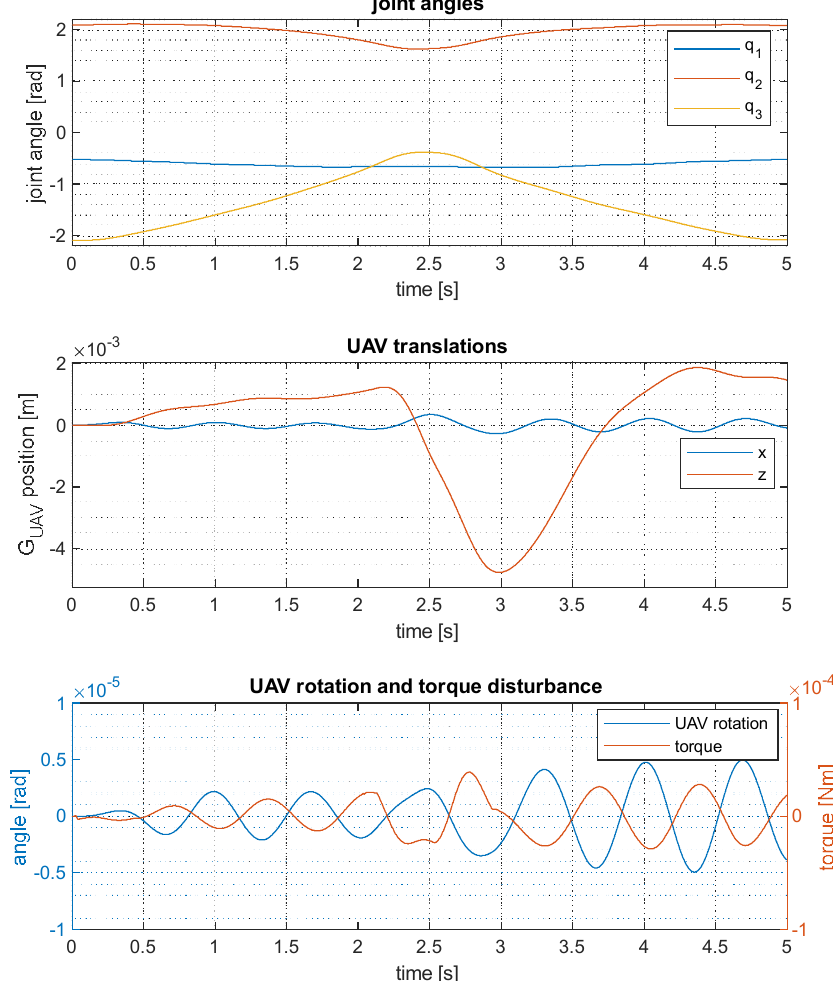
Figure 18. Manipulator ( top ) and UAV motions and torque disturbance ( middle and bottom ) for the linear trajectory task with the 3-DOF UAM using the extended Jacobian.